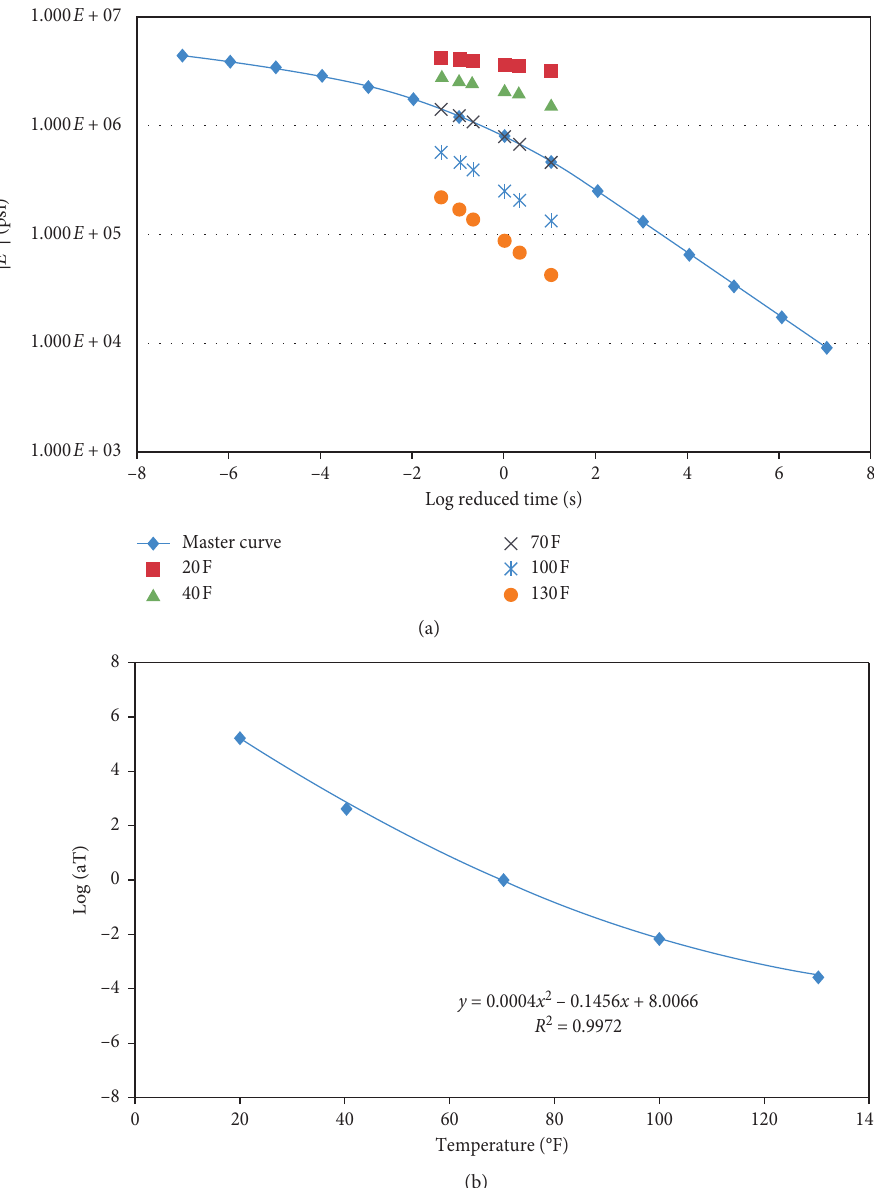
Figure 3: Examples of (a) predicted E ∗ master curve for S3+ 40% RAP and (b) shift